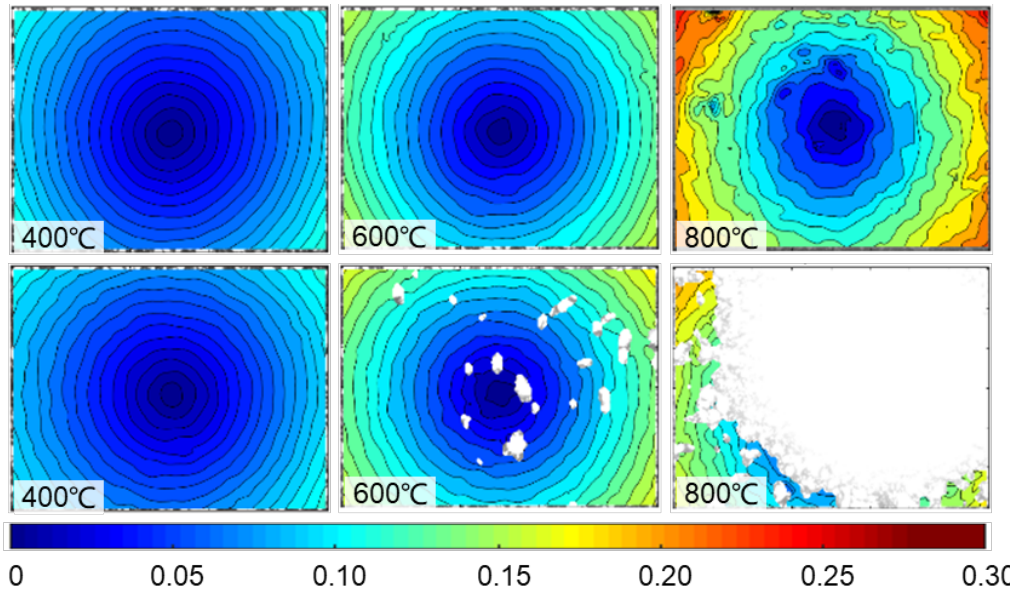
Figure 11. The estimated radial displacement by the image pairs captured with two different exposure modes ( top : auto exposure mode; bottom : fixed exposure mode) at 400 °C, 600 °C, and 800 °C.